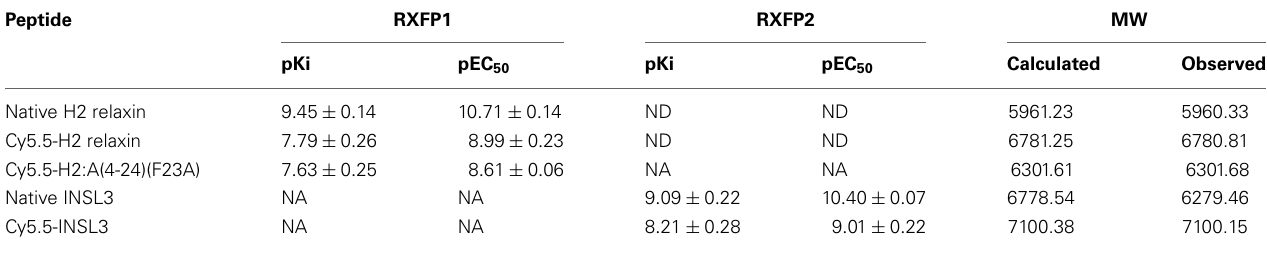
Table 1 | Competition binding (pKi) and activation (pEC 50 ) by H2 relaxin analogs of RXFP1, and by INSL3 analogs of RXFP2, and molecular weight of